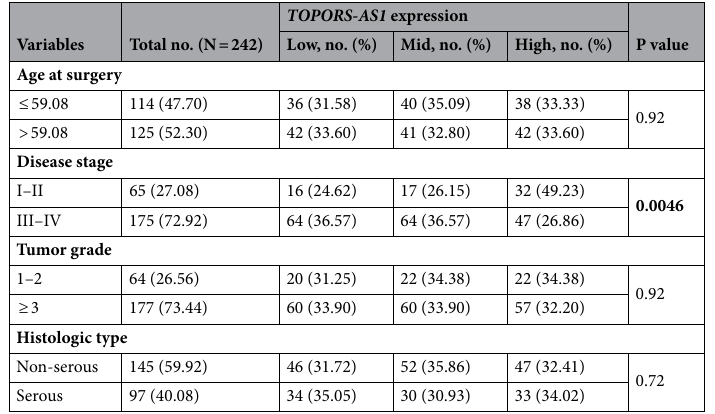
Table 1. Associations of TOPORS-AS1 with clinicopathological factors of ovarian cancer. Bold indicates p<0.05.